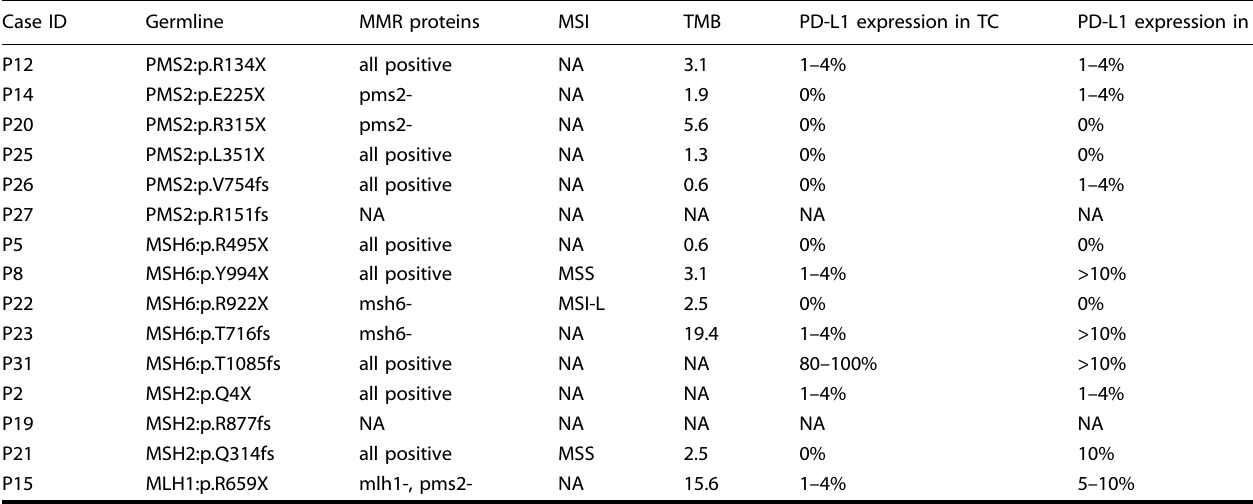
Table 4. MMR/PD-L1 protein expression and TMB of breast cancers with pathogenic germline variants in MMR